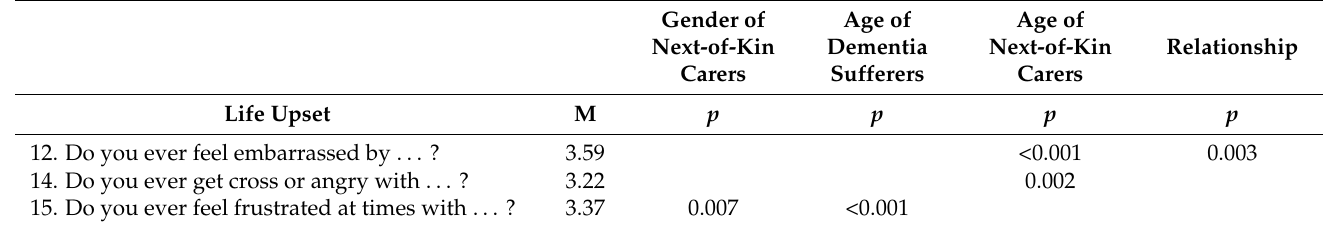
Table 4. Differences in RSS evaluation based on selected